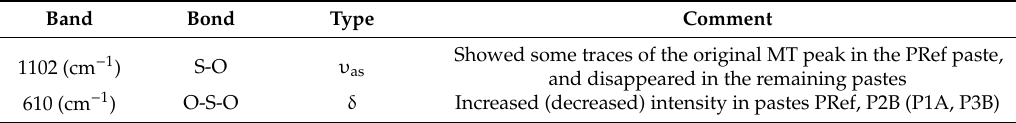
Table 4. Summary of the sulphur-related peaks presented in Figure